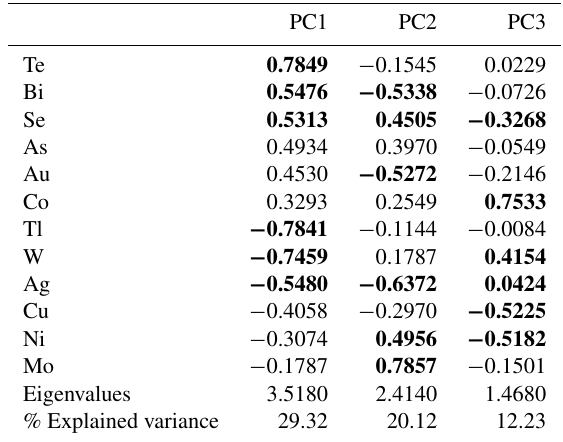
Table 4. Results from principal component analysis from the n = 260 trace element data from pyrite, including the 12 variables in re- lation to the first three principal components, which contain most of the data variance (see corresponding eigenvalues). The proportion of the variance in each eigenvector is displayed as the percentage of the explained variance. The first three elements with the largest positive and negative loadings along the positive and negative axis of each PC are marked in bold